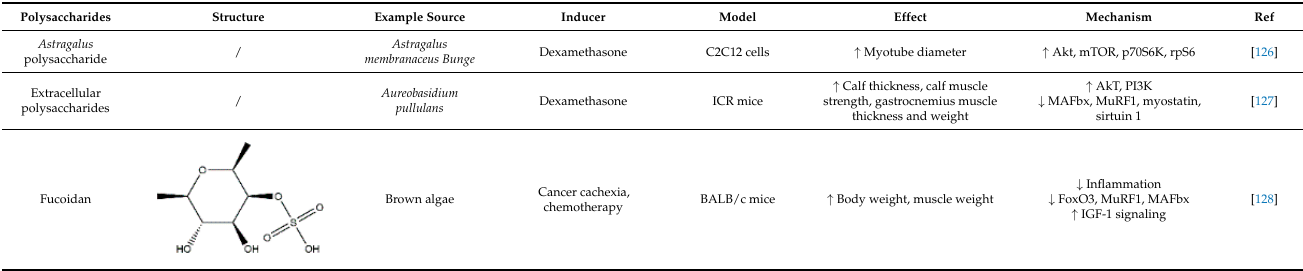
Table 7. Polysaccharides in the prevention of the muscle atrophy in vitro/vivo.